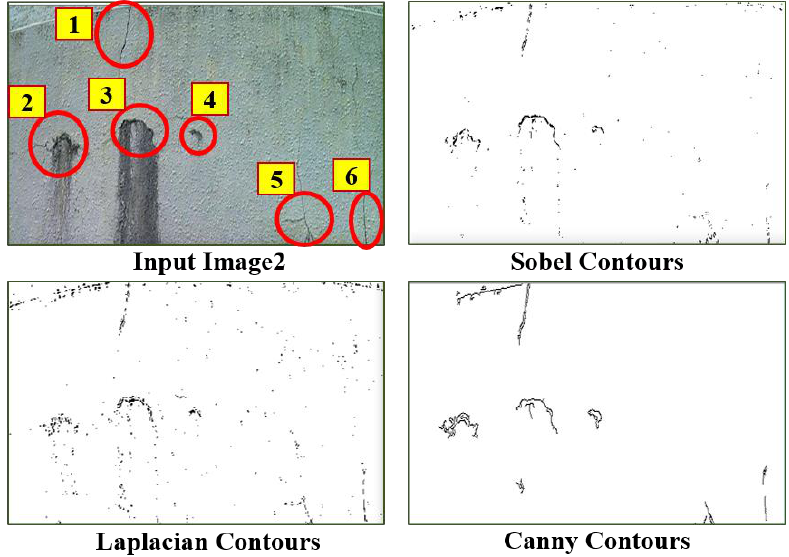
Figure 11. Comparison of the contour detectors with 6 cracks.